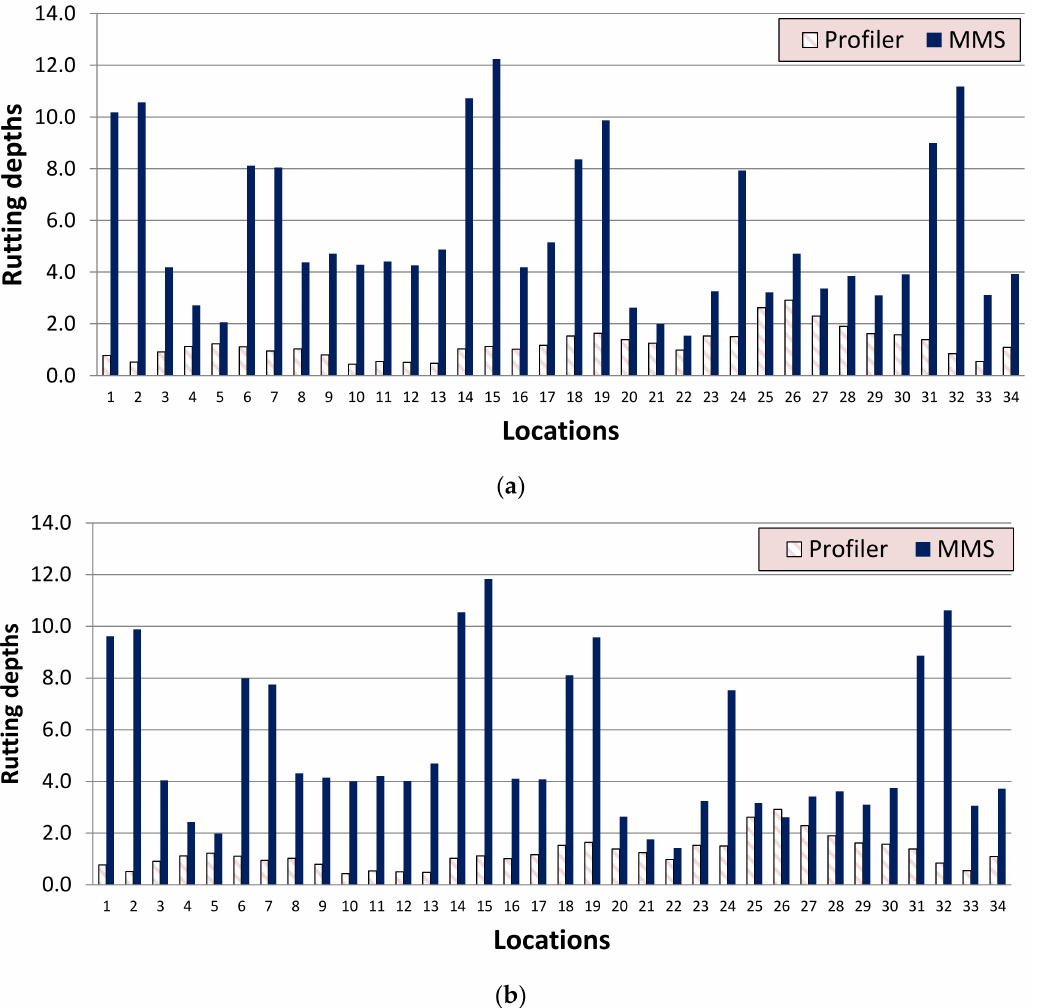
Figure 18. Comparison of rutting depths measured by profilometer and MLS for mesh sizes of ( a ) 5 cm and ( b ) 10 cm.